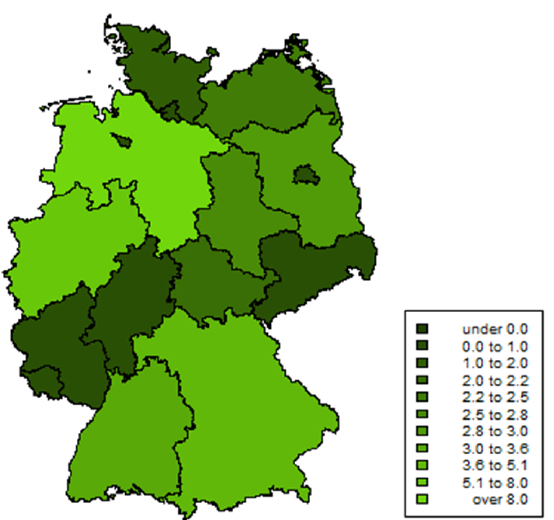
Figure 1. Choropleth of the proportion of (fluoro)quinolone-resistant and qnr -positive E. coli recov- ered during the ZoMo- and ESBL-monitoring in Germany in 2017. Prevalence was calculated as the proportion of (fluoro)quinolone-resistant and qnr -positive E. coli isolates divided by all investigated samples per federal state.